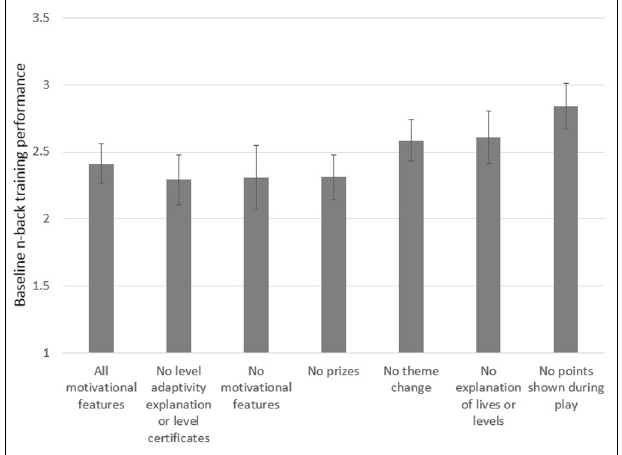
FIGURE 4 |Average game performance (n-back level) at baseline for each game version. Error bars represent standard error.